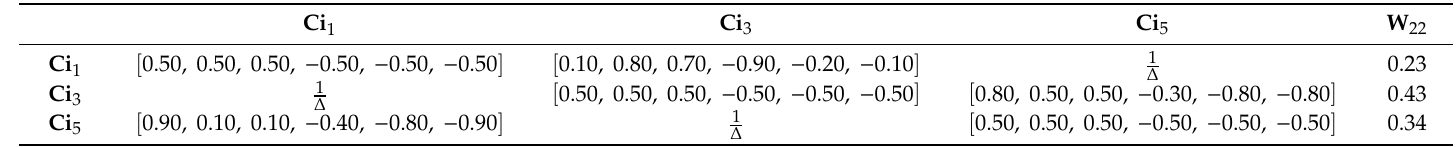
Table 12. Interior interdependencies matrix of factor C 7 .